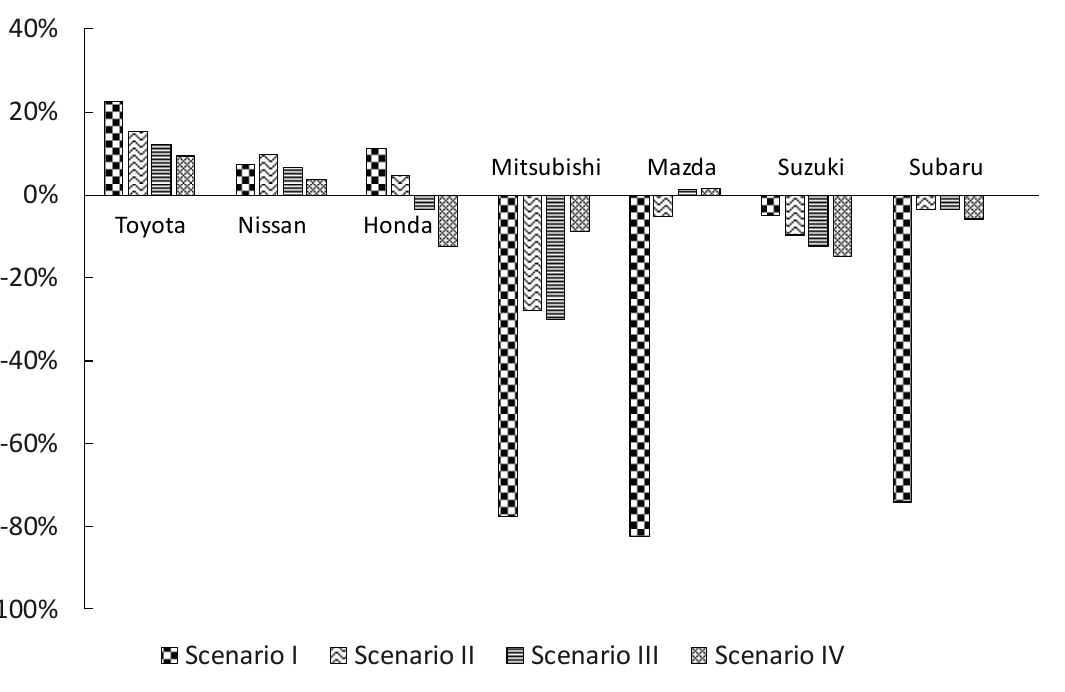
Figure 2. Percentage changes in lifecycle CO 2 emissions under optimal scenarios I–IV relative to the actual emissions.